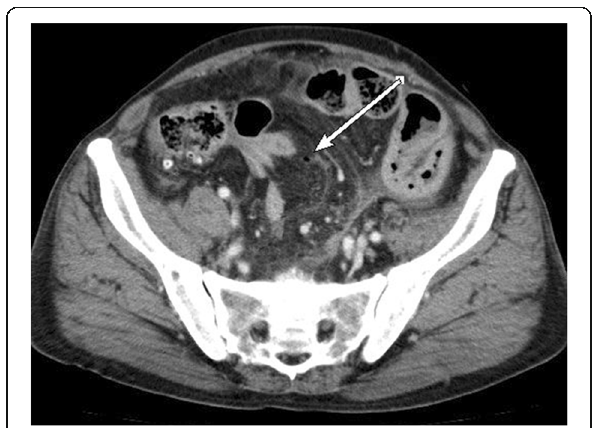
Fig. 1 Computed tomographic findings: abdominal and pelvic computed tomography scan showing free air bubbles near the small